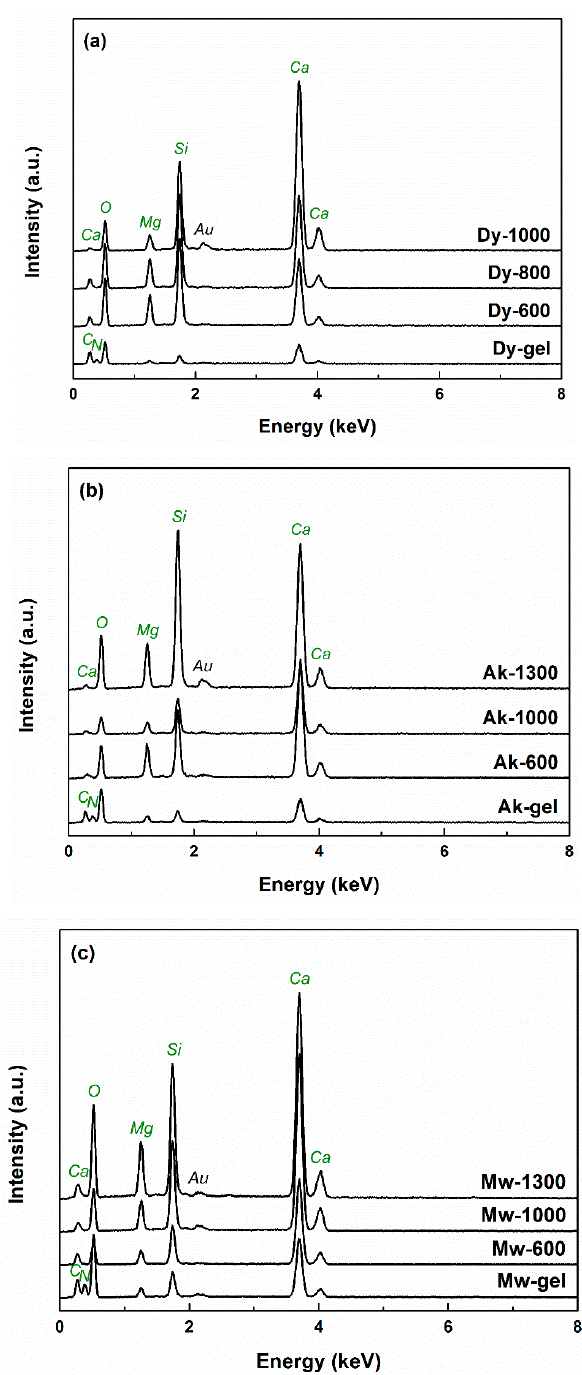
Figure 6. EDX spectra of the dry gels and ceramics corresponding to: ( a ) diopside; ( b ) akermanite; and ( c ) merwinite